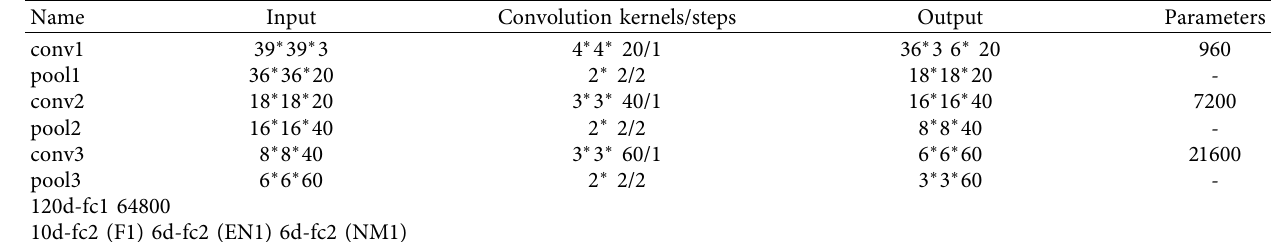
Table 2: Network structure table of the first stage.